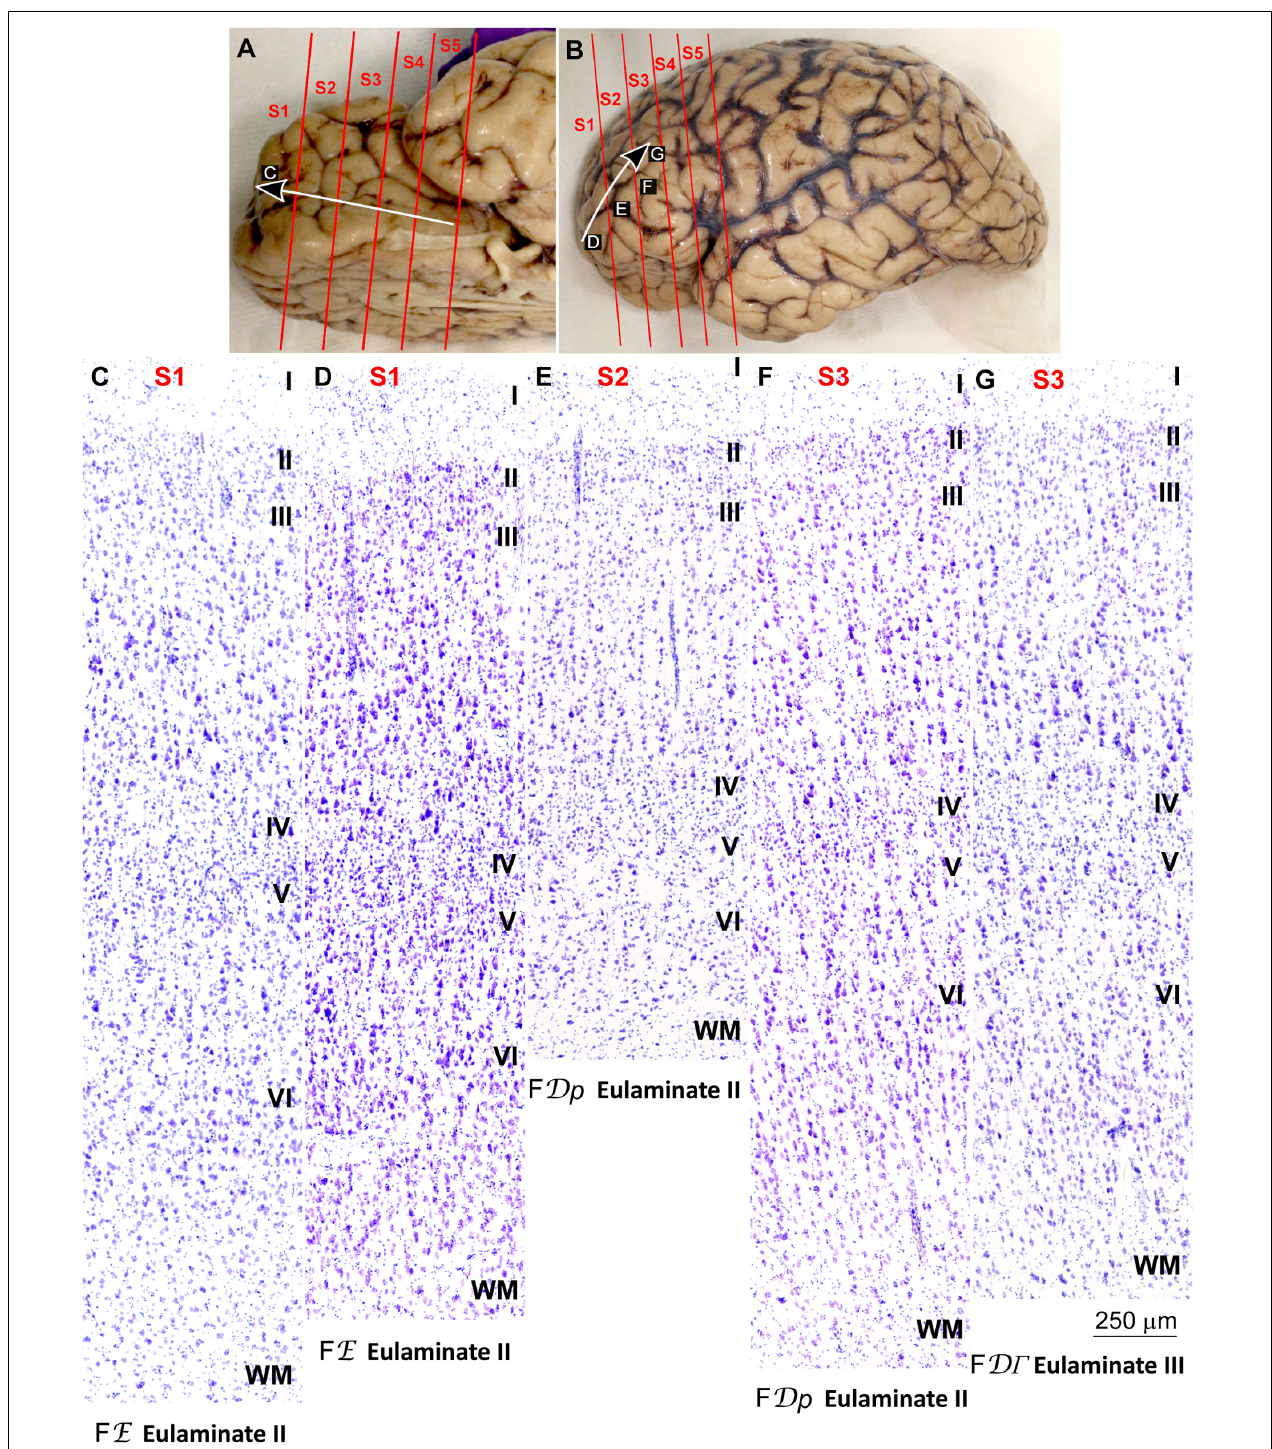
FIGURE 3 | Systematic and gradual variation of laminar structure across areas of the paraolfactory trend in the human prefrontal cortex: Frontopolar and dorsolateral prefrontal areas. (A,B) , Orbital (A) and lateral (B) views of the left hemisphere from the brain (case HCD): red lines show the planes of separation of coronal slabs; black and white arrows indicate laminar differentiation along the paraolfactory trend. (C–G) , Micrographs of the frontopolar and dorsolateral prefrontal cortex in Nissl stained sections at the levels indicated in (B) ; the areas according to the Atlas of von Economo and Koskinas (1925/2008) and the cortical type are indicated below each micrograph; see the text for description of laminar features. S1, S2, S3, S4, S5, indicate coronal slabs from anterior to posterior; WM, white matter. Roman numerals indicate cortical layers. Calibration bar in (G) applies to (C–G)